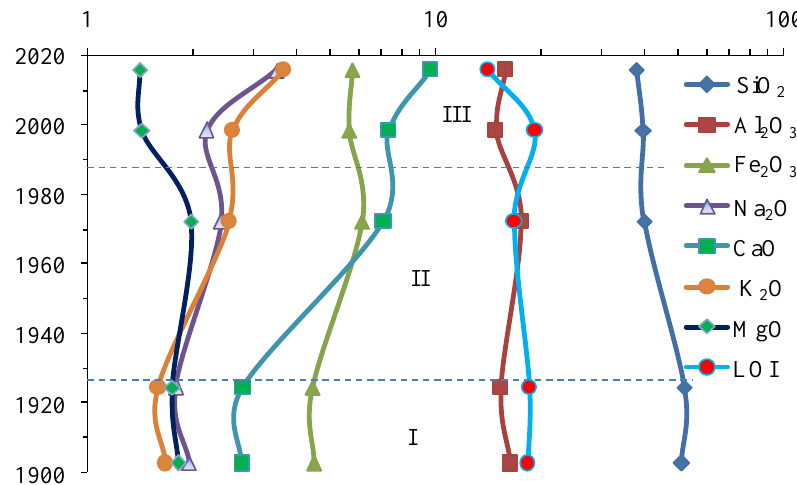
Figure 4. Vertical distribution of the content (%) of the main elements and organic matter (LOI) in the sediment core of Lake Bolshoy Vudjavr.